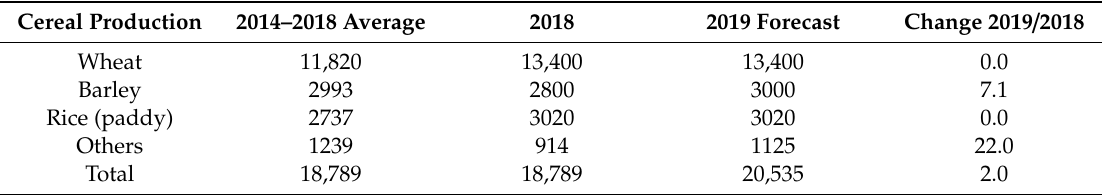
Table 2. Overall wheat production in Iran in 1000 tones for Iran